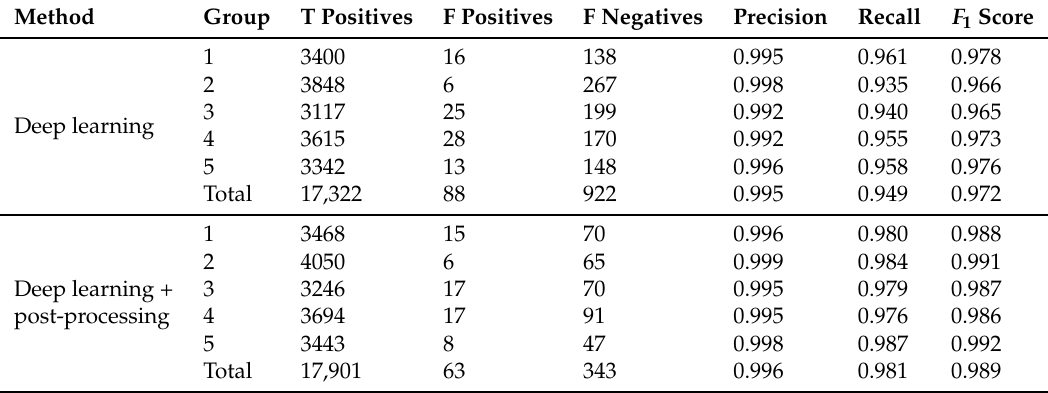
Table 3. The precision, recall and F 1 score metrics for panel detection in thermal images using deep learning method, before and after